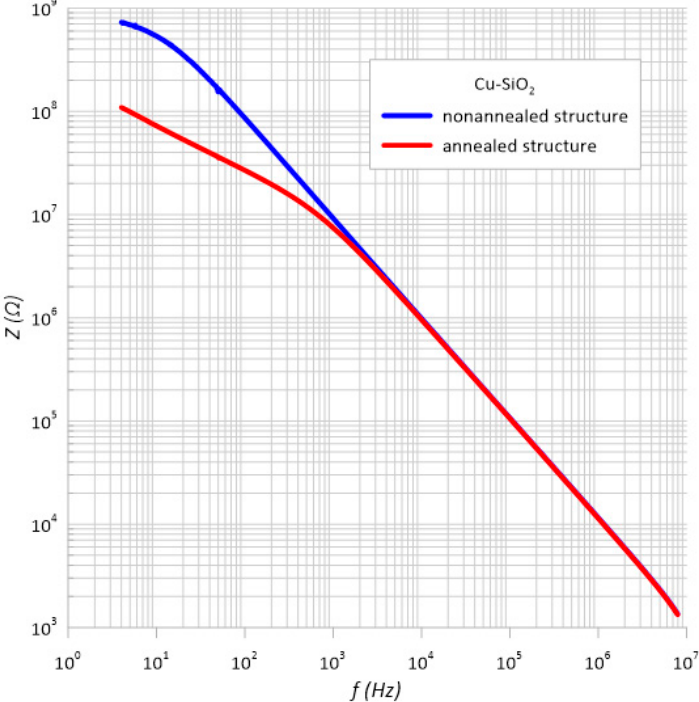
Figure 11. Dependence of impedance on the frequency of an unheated and heated structure.